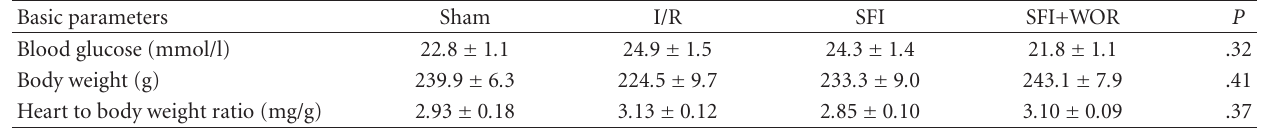
Figure 3: Plasma creatine kinase (CK) and lactate dehydrogenase (LDH). I/R: ischemia/reperfusion; SFI: Shen-fu injection; WOR: wortmannin. Values presented are mean ± SEM. n = 8, ∗ P < . 05 versus Sham, # P < . 05 versus I/R, and α P < . 05 versus SFI. Table 1: Basic parameters of the rats.